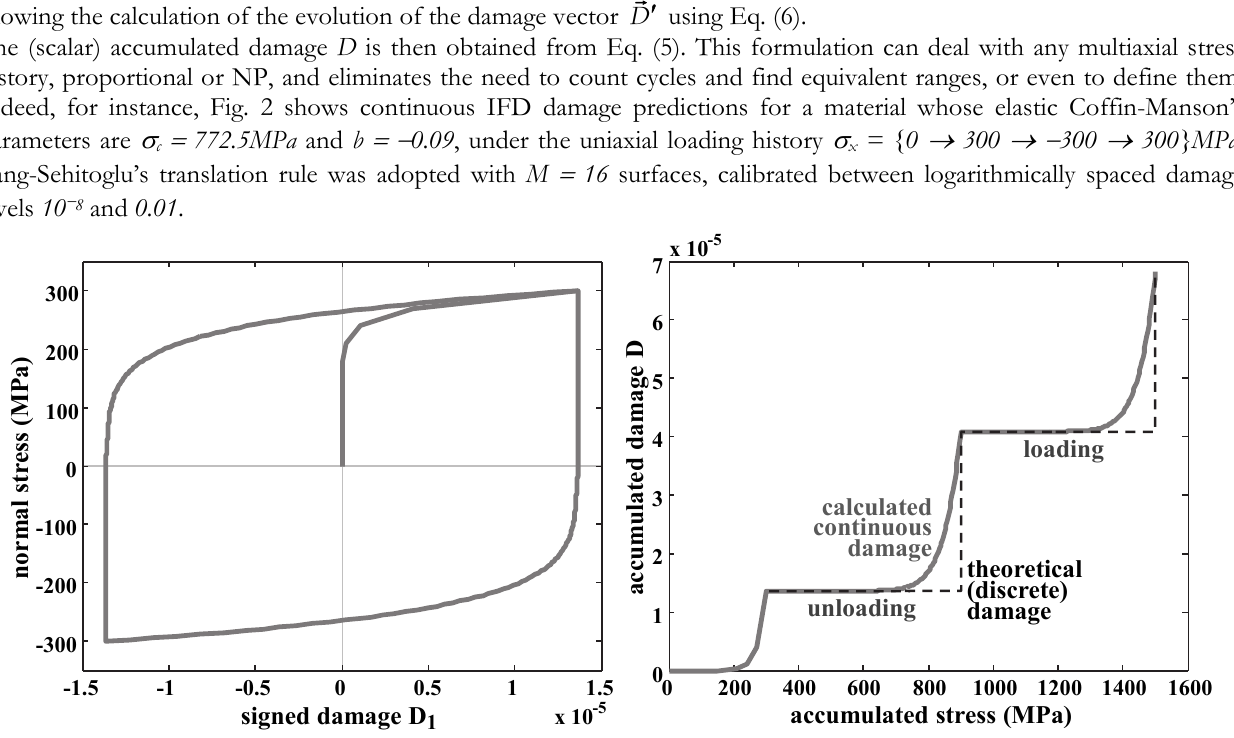
Figure 2: Hysteresis loops relating applied stress and a signed damage state (left) and resulting accumulated damage (right) for a uniaxial constant amplitude loading